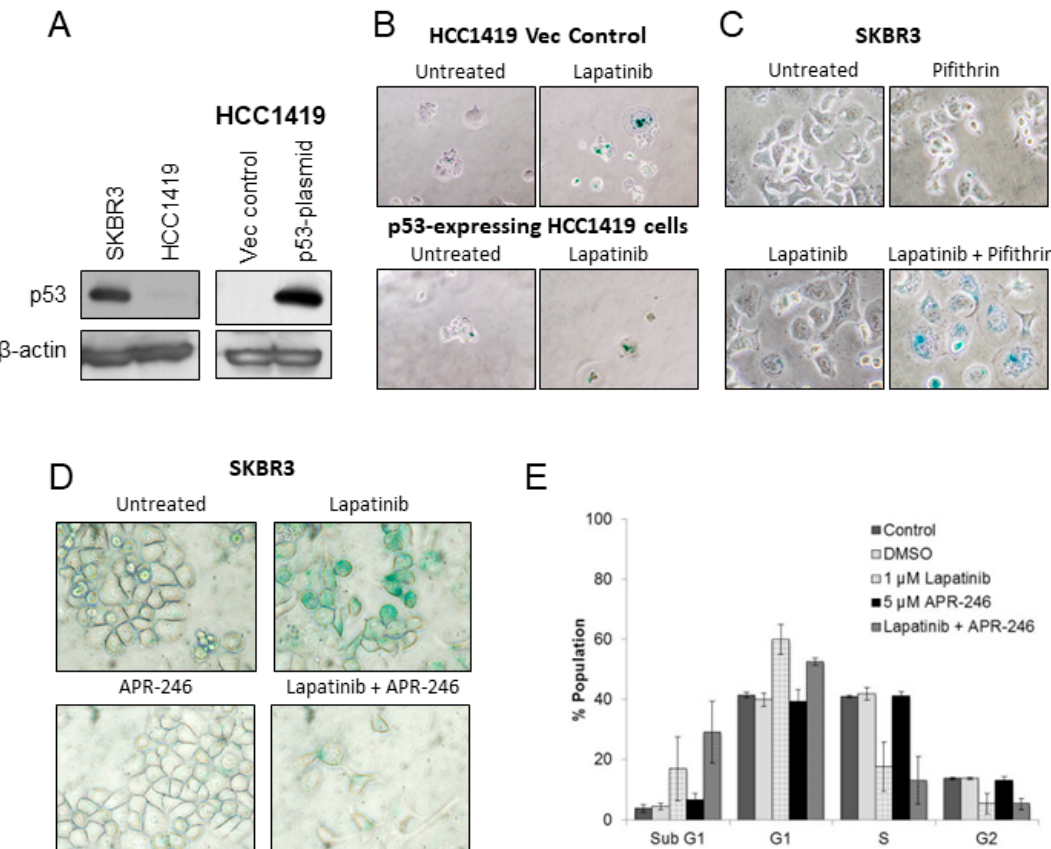
Figure 3. ( A ) Protein expression levels of p53 in SKBR3 and HCC1419 cells. HCC1419 cells were transfected with either empty control vector (vec control) or wild-type p53 plasmid and the resulting expression of p53 was analyzed by western blotting. β -actin was used as a loading control. ( B ) SA- β -gal activity in HCC1419 empty vector control cells and p53-expressing cells with and without 250 nM lapatinib. ( C ) SA- β -gal activity in SKBR3 cells treated with pifthrin (100 nM) alone and in combination with lapatinib (250 nM) for 1 week. ( D ) SA- β -gal activity in SKBR3 cells treated with lapatinib (250 nM) and/or APR-246 (5 µ M) for 2 weeks. ( E ) Cell cycle analysis of SKBR3 cells treated with lapatinib (250 nM) and/or APR-246 (5 µ M) for 5 days (error bars reflect n = 3). Images taken at 400 × magnification.